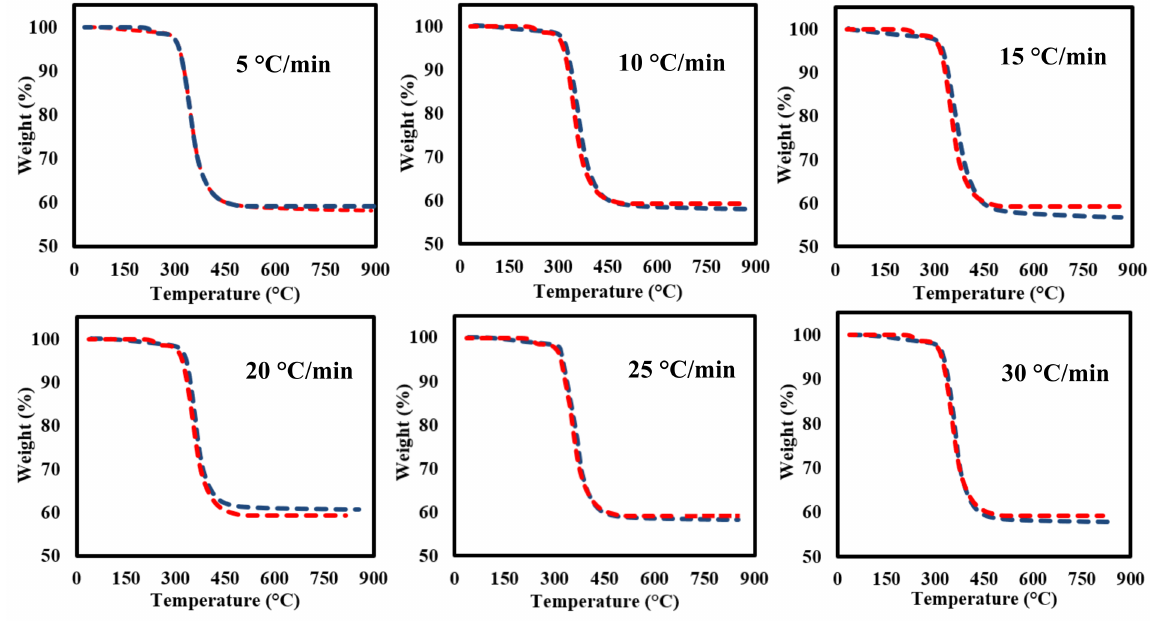
Figure 9. TGA experimental and calculated data at 5–30 ◦